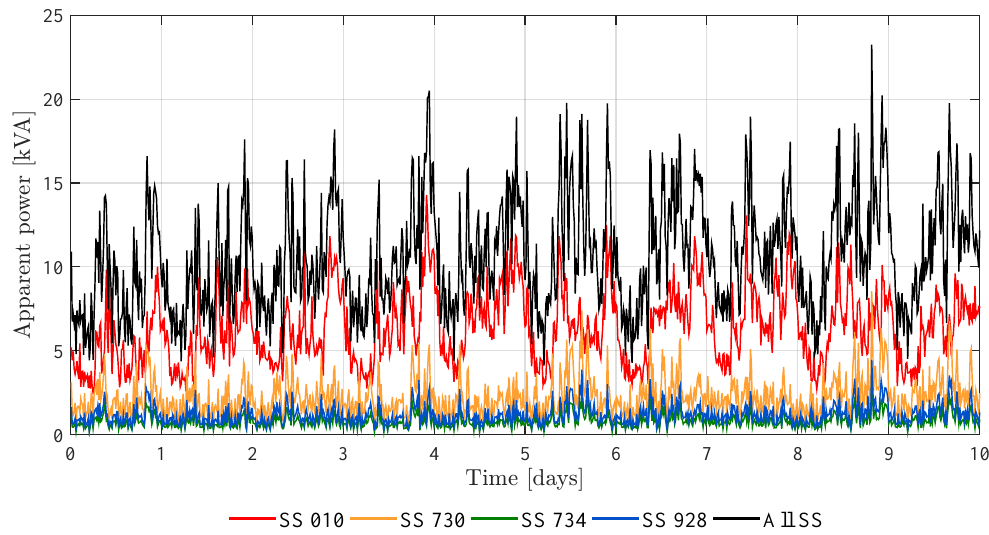
Figure 10. Total apparent power feed by each SS and the Pilot Network (PN) during 10 days.